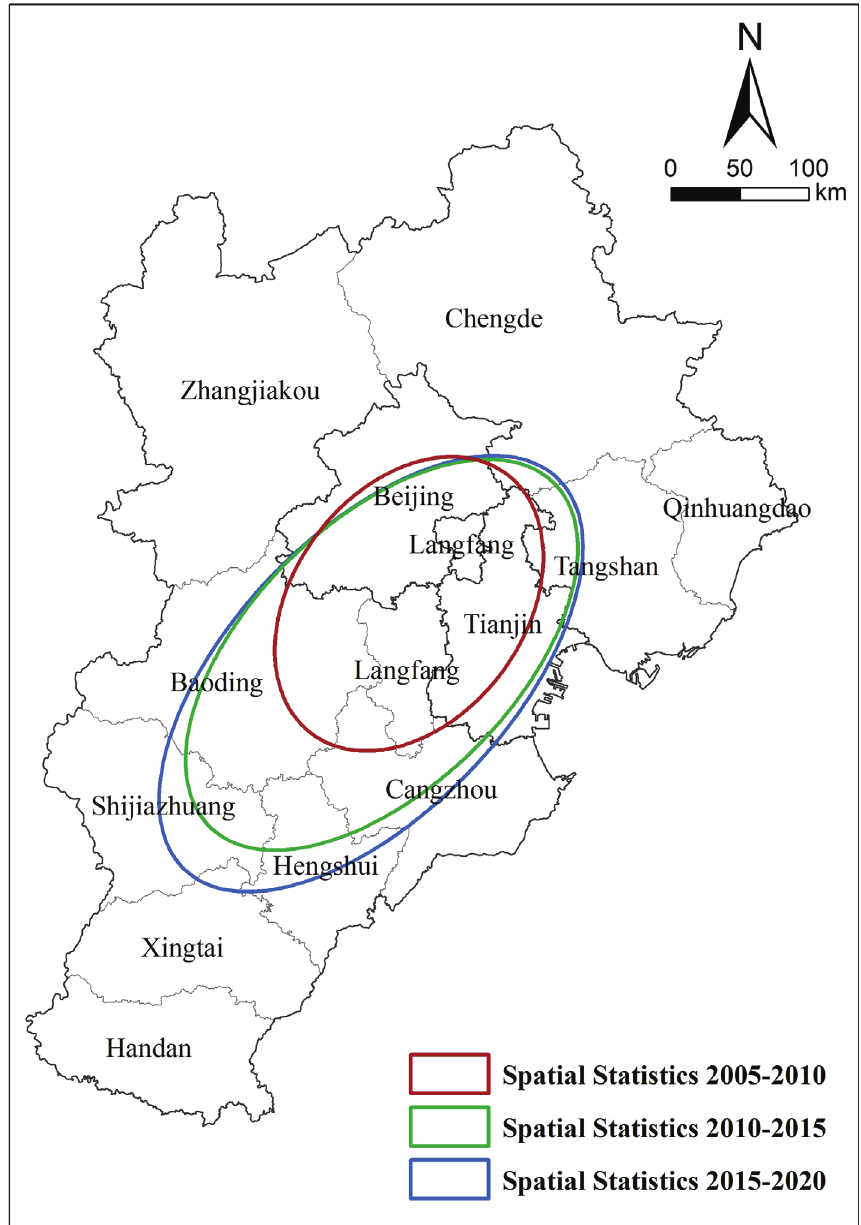
Fig. 4. SDE movement of Beijing – Tianjin – Hebei Renewable Energy